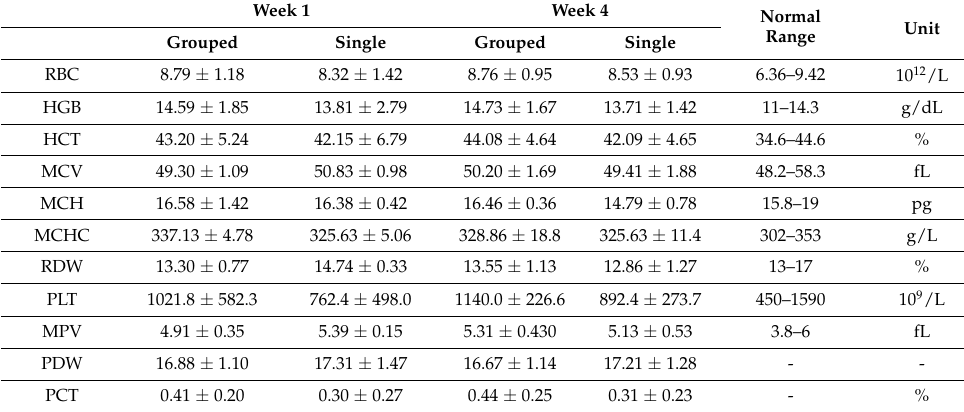
Table 2. Red blood cell and platelet